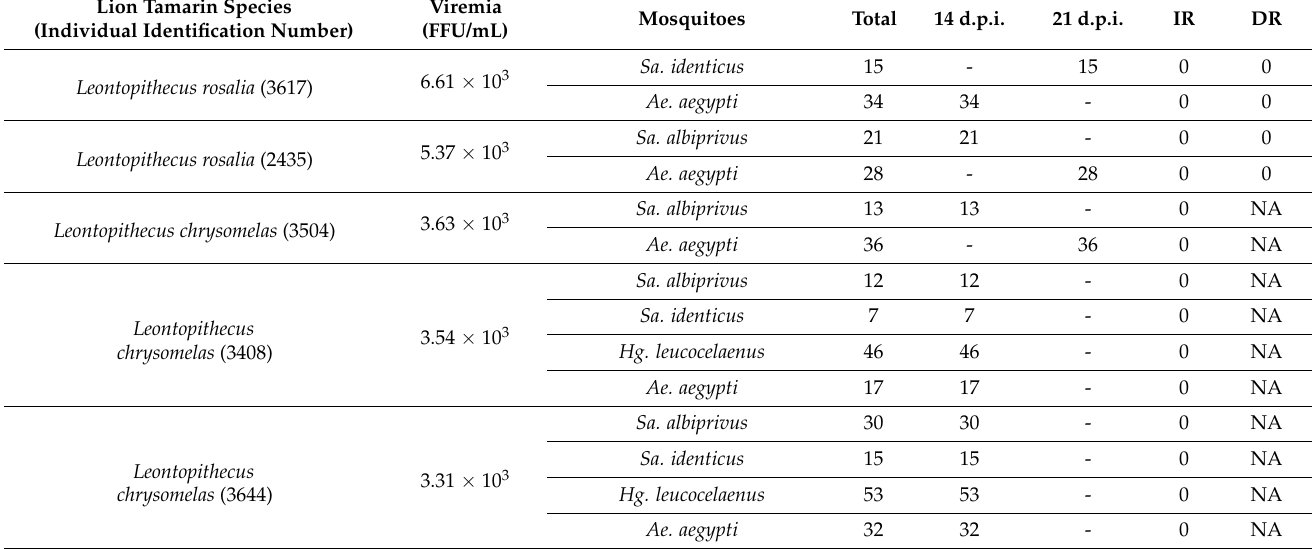
Table 1. Lion tamarin species, viremia at the time of mosquito feeding and number of mosquitoes by species examined at two incubation times (14 and 21 d.p.i.) after feeding on viremic YF 17DD- vaccinated lion